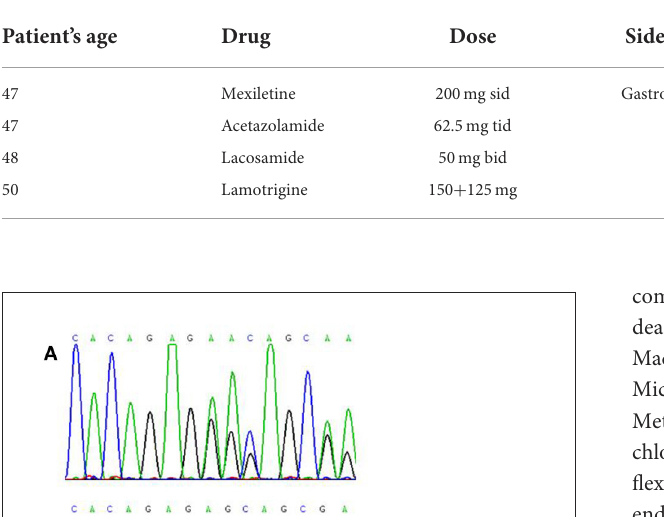
TABLE 2 Timeline of the drug treatments administered to the patient and their effects.